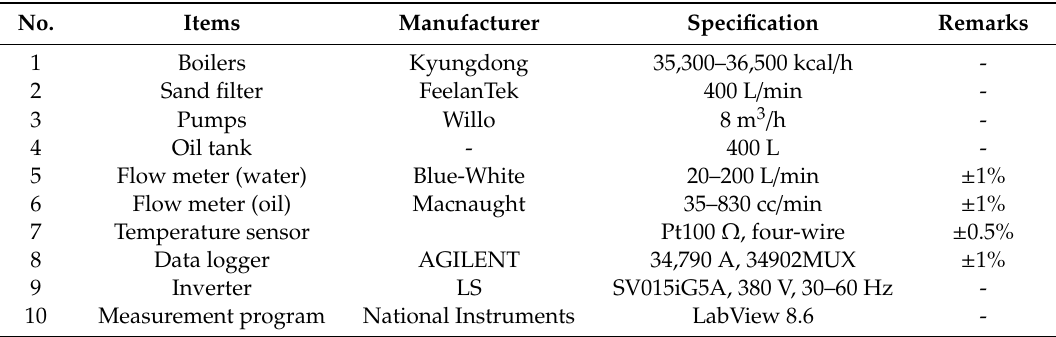
Figure 4. Schematic diagram of the measurement apparatus of the SCW system. Table 1. Specifications of the thermal response test rig.